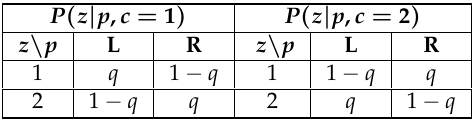
Table 1. A simple observation function. The left side of the table shows the probabilities of class observations z when the true class is c = 1; and the right side shows the case when c = 2. For instance, when c = 1 and the viewpoint is R, the robot observes the correct class with probability 1 − q .